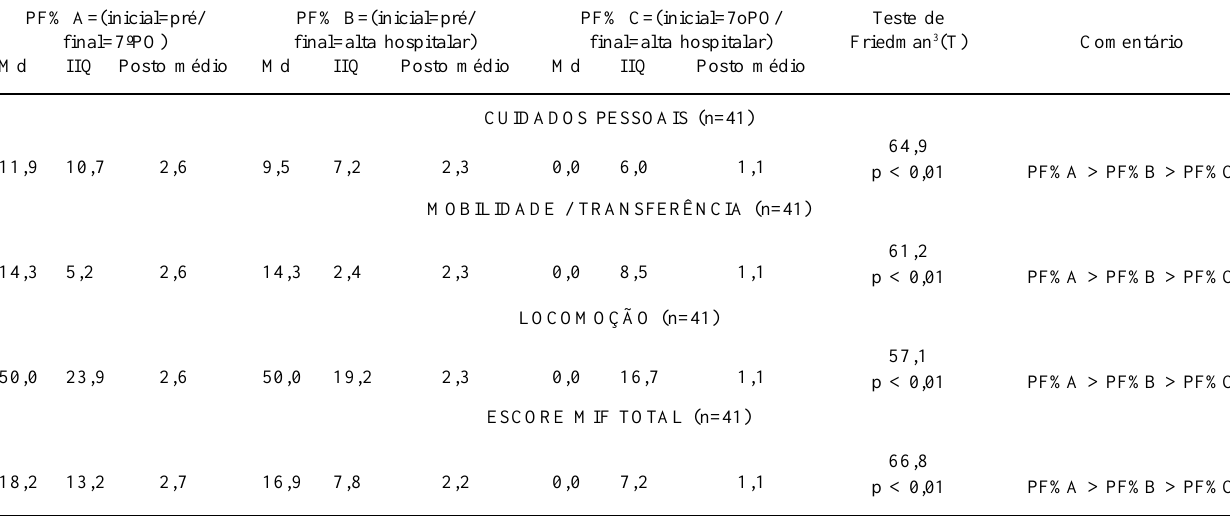
Tabela 4. Medidas de posição, dispersão, resultados dos testes e comentário, entre os momentos Pré, 7º dia pós-operatório (7º PO) e Alta hospitalar, segundo as categorias Cuidados Pessoais, Mobilidade/Transferência, Locomoção e escore MIF total. PF% A=(inicial=pré/